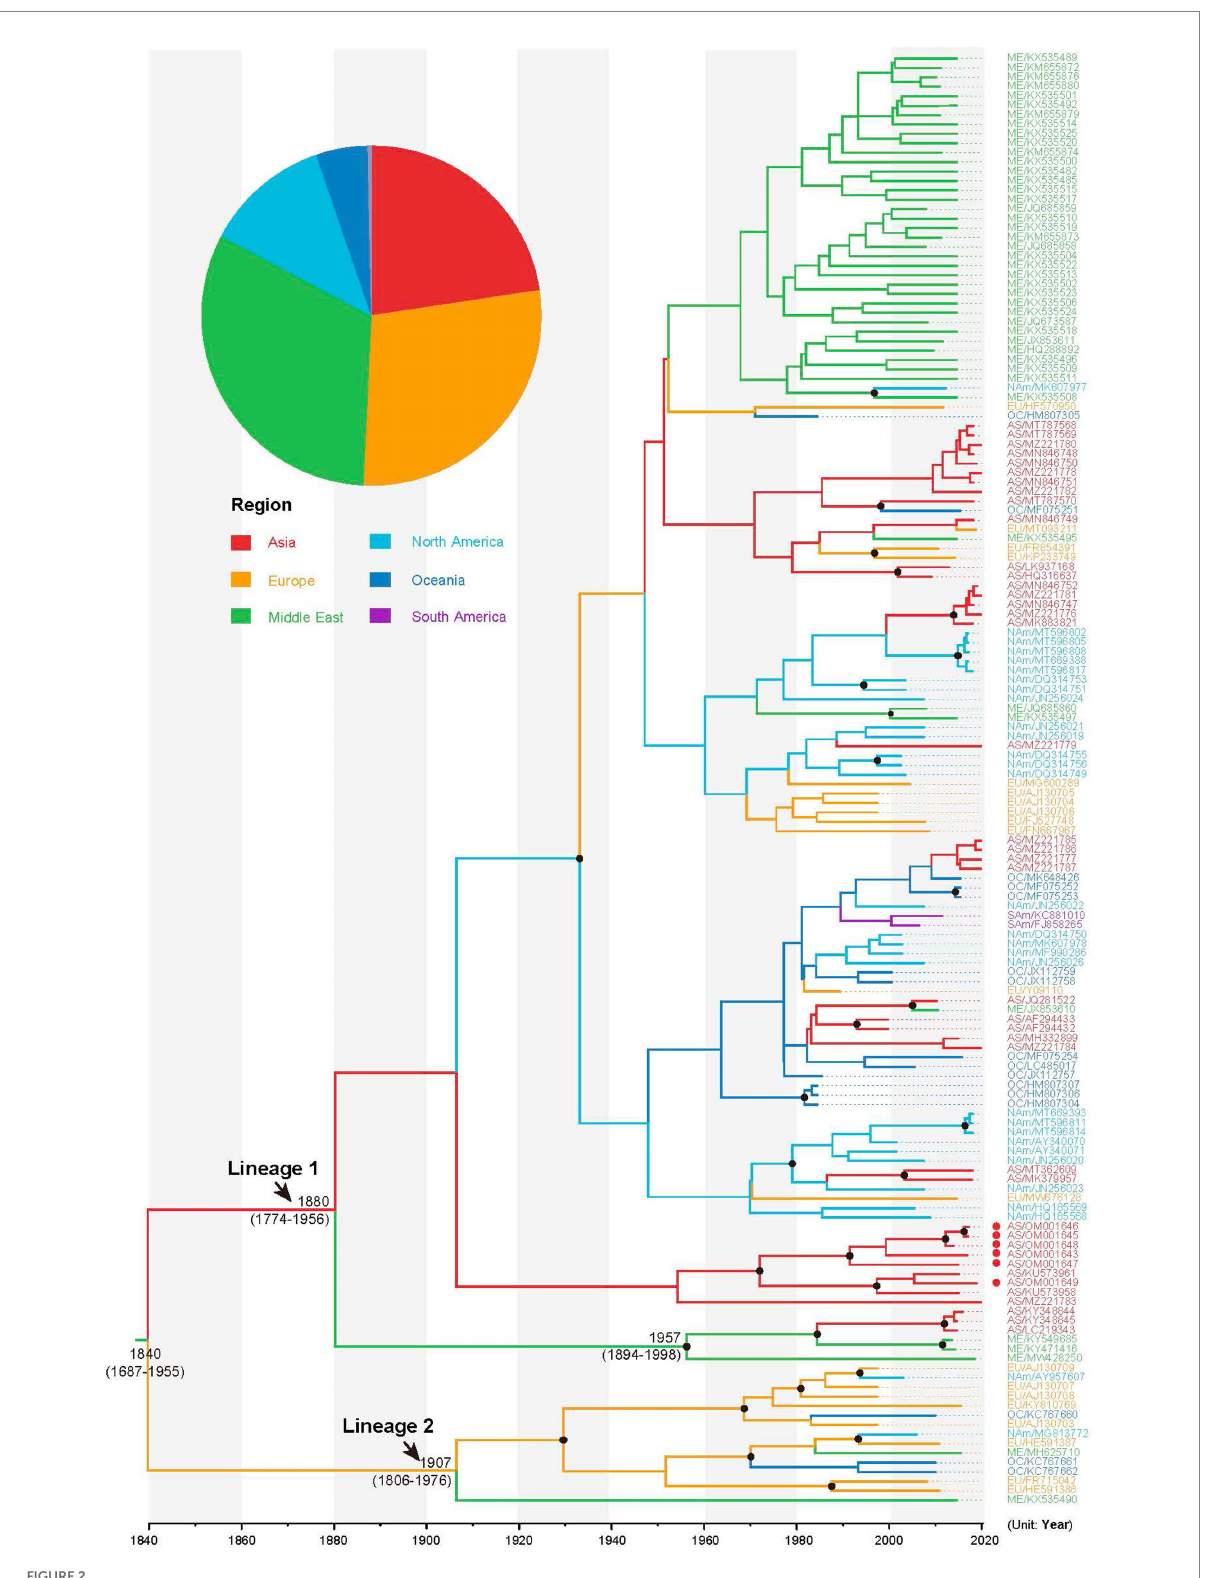
FIGURE 2 Maximum clade credibility tree inferred from the CP sequences of alfalfa mosaic virus (AMV). The tree topology has been chosen to maximize the product of node posterior probabilities and the tree branches have been color-coded according to their geographic origins. The inferred probability of the root for each geographic region is shown in the pie charts. Black circles indicate strong node support with posterior probability >0.95. AMV isolates sequenced in this study are indicated in red